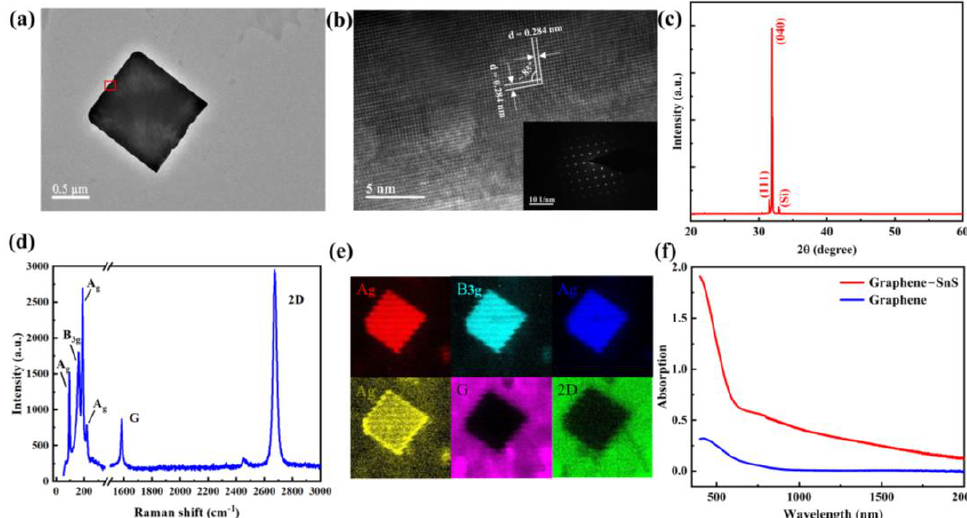
Figure 1. ( a ) The TEM image of a single SnS nanoflake; ( b ) The HR-TEM image of SnS nanoflakes marked by the red square in panel a; Inset: SAED pattern. ( c ) The X−ray diffraction pattern of SnS nanoflakes on SiO 2 /Si substrate. ( d ) The Raman spectra of graphene/SnS nanoflakes heterostructure. ( e ) The Raman mapping of a randomly selected graphene/SnS nanoflakes heterostructure. ( f ) The UV−Vis to NIR absorbance spectra of graphene and SnS nanoflakes/graphene heterostructure.